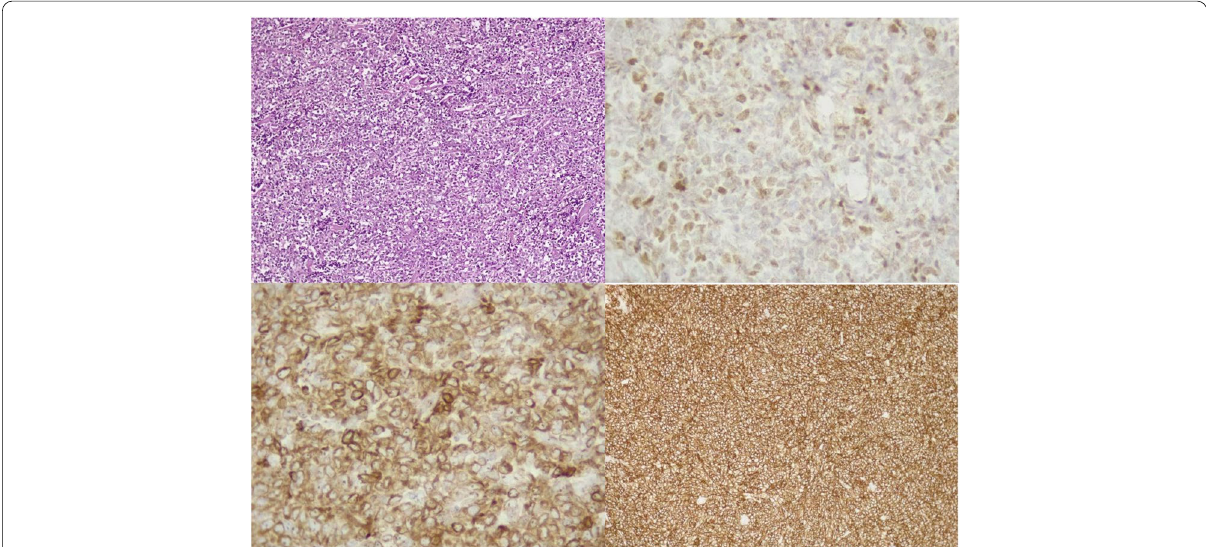
Fig. 3 Histopathologic examination; respectively from left to right: H & E staining*10, immunohistochemistry study for Bcl6, Bcl2, and CD20